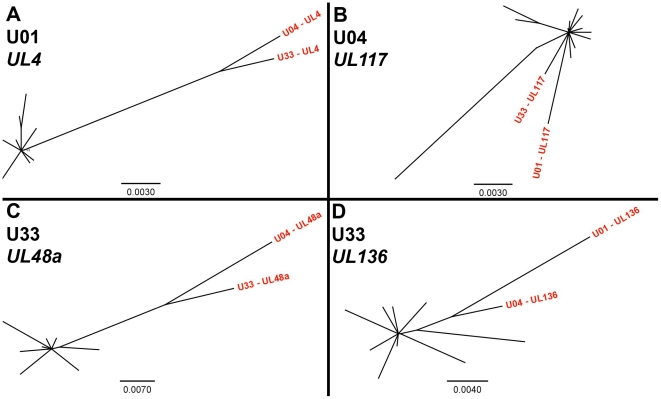
Unrooted phylogenetic trees of HCMV populations show varying levels of diversity.Highly variable ORFs in the high throughput sequencing dataset of each patient sample were selected for clonal Sanger sequencing. Unrooted phylogenetic trees were generated from the data, and major genotype sequence data from the other patient samples in this study were included to provide perspective (shown in red text). The trees from some datasets showed clones that were unique but closely related (5A, 5C). The clones from others datasets were more divergent, such that divergence within a patient sample was larger than divergence between patient samples (5B, 5D). Examples of both patterns could be seen at different ORFs from the same patient sample (5C, 5D). Phylogentic trees generated from all Sanger datasets can be seen in Figure S7. Units for scale bars are substitutions per site.